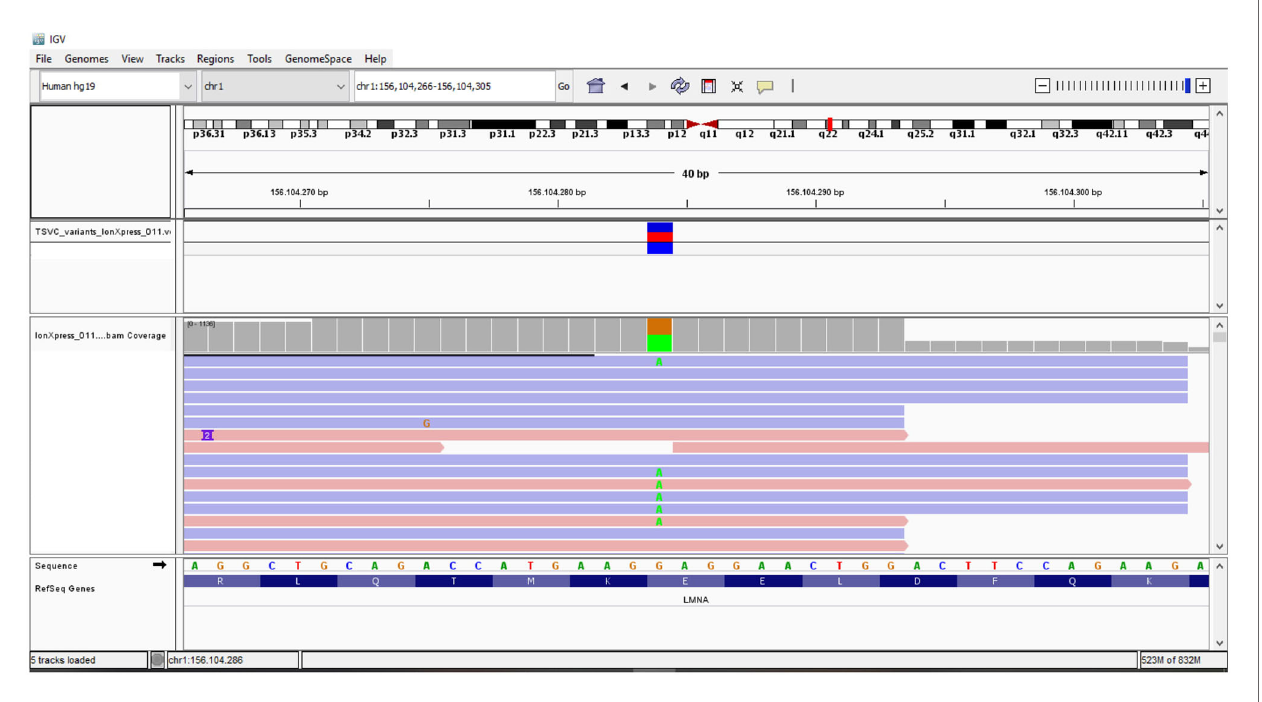
FIGURE 2 | Body fat distribution pattern of the